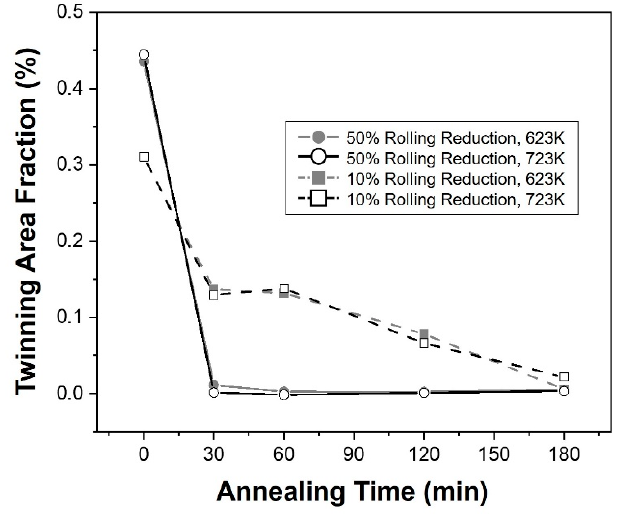
Figure 6. Graph showing the relationship between annealing time and twinning fraction in the result of microstructure.